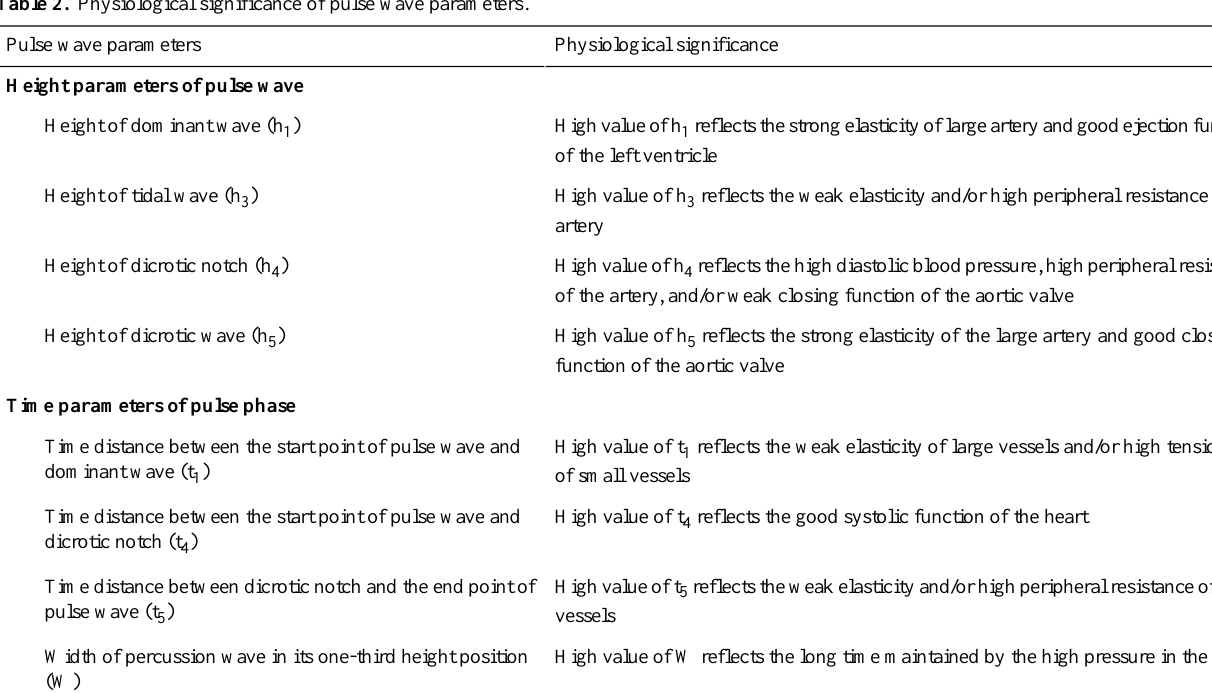
Table 2. Physiological significance of pulse wave